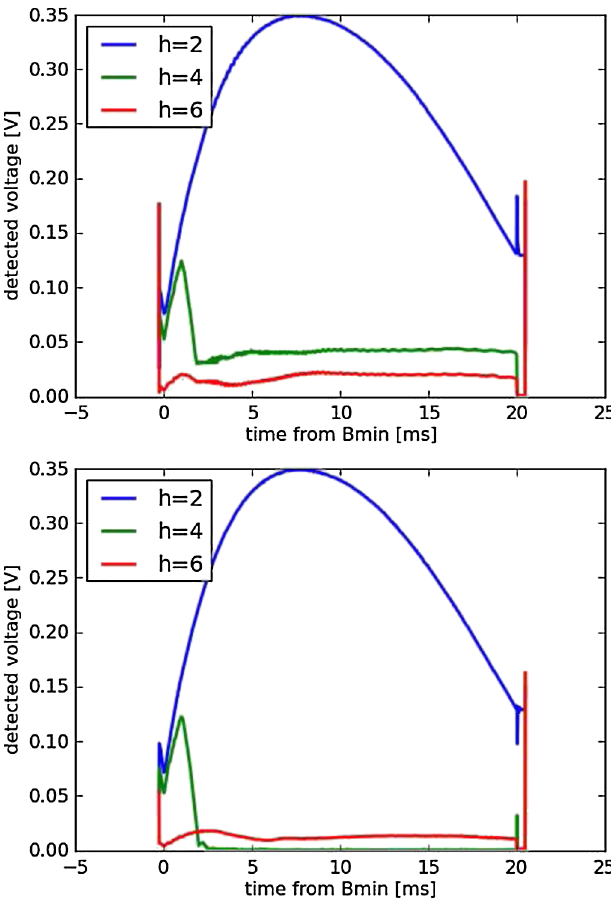
plotted.FIG. 14. The harmonic components of cavity #1 gap monitor—(top) without the feedforward, (bottom) with the feed- forward after the iterations of the step